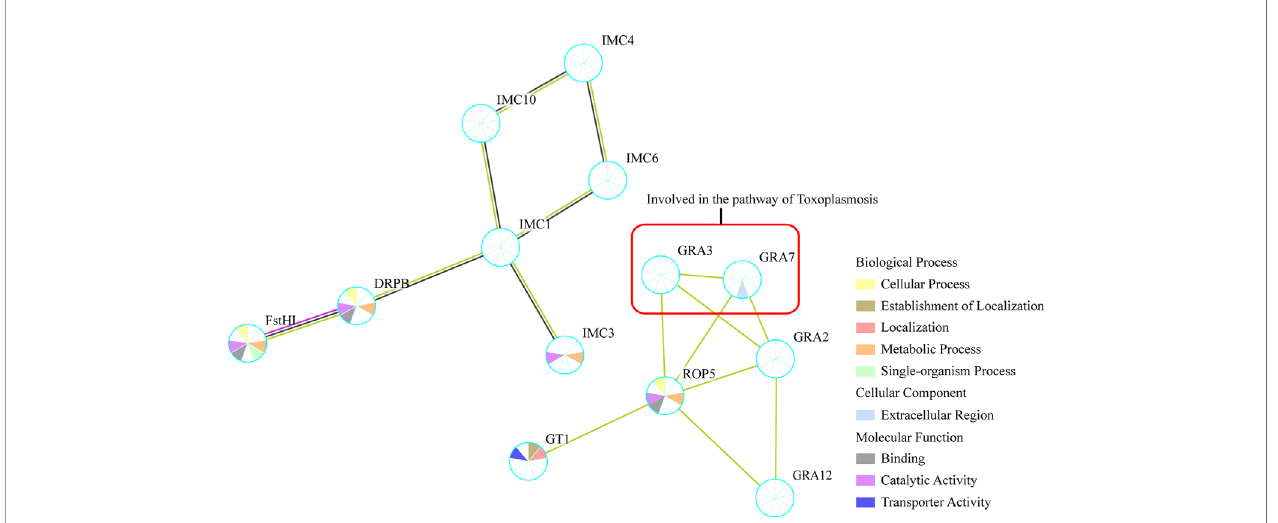
FIGURE 4 | Protein – protein interaction (PPI) networks of all the identi fi ed phosphoproteins. The PPI network was generated with the identi fi ed tachyzoites phosphoproteins via STRING v11.0 with a con fi dence score over 0.7. GRA3 and GRA7 within red box were suggested to be involved in the regulation of Toxoplasmosis pathway.